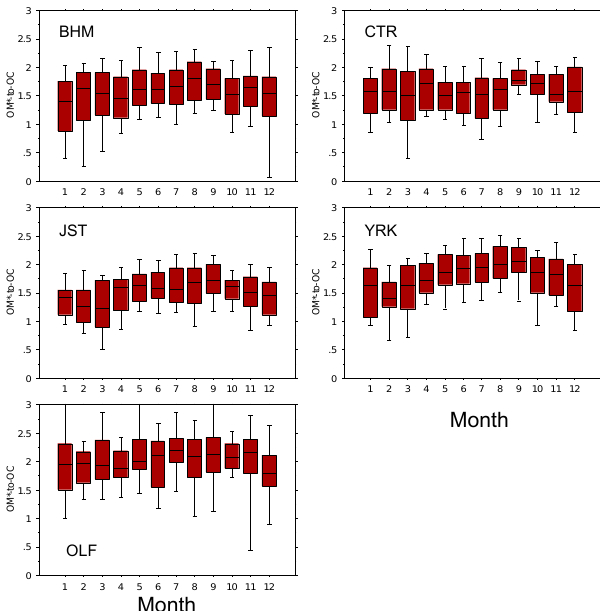
Figure 2. Statistical distributions of the ratio OM* / OC computed for daily-average measurements at SEARCH sites, 2009–2013. The distributions show the 10th, 25th, 50th, 75th, and 90th percentiles. OM* is the sum of measured OC and the computed difference of PM 2 . 5 mass minus the sum of measured species